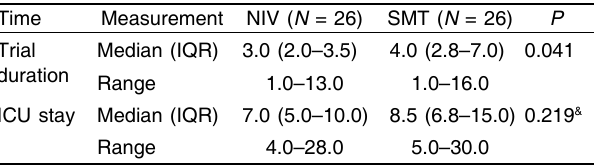
Table 4 Comparison between the study groups as regards trial duration and ICU stay (days) Time